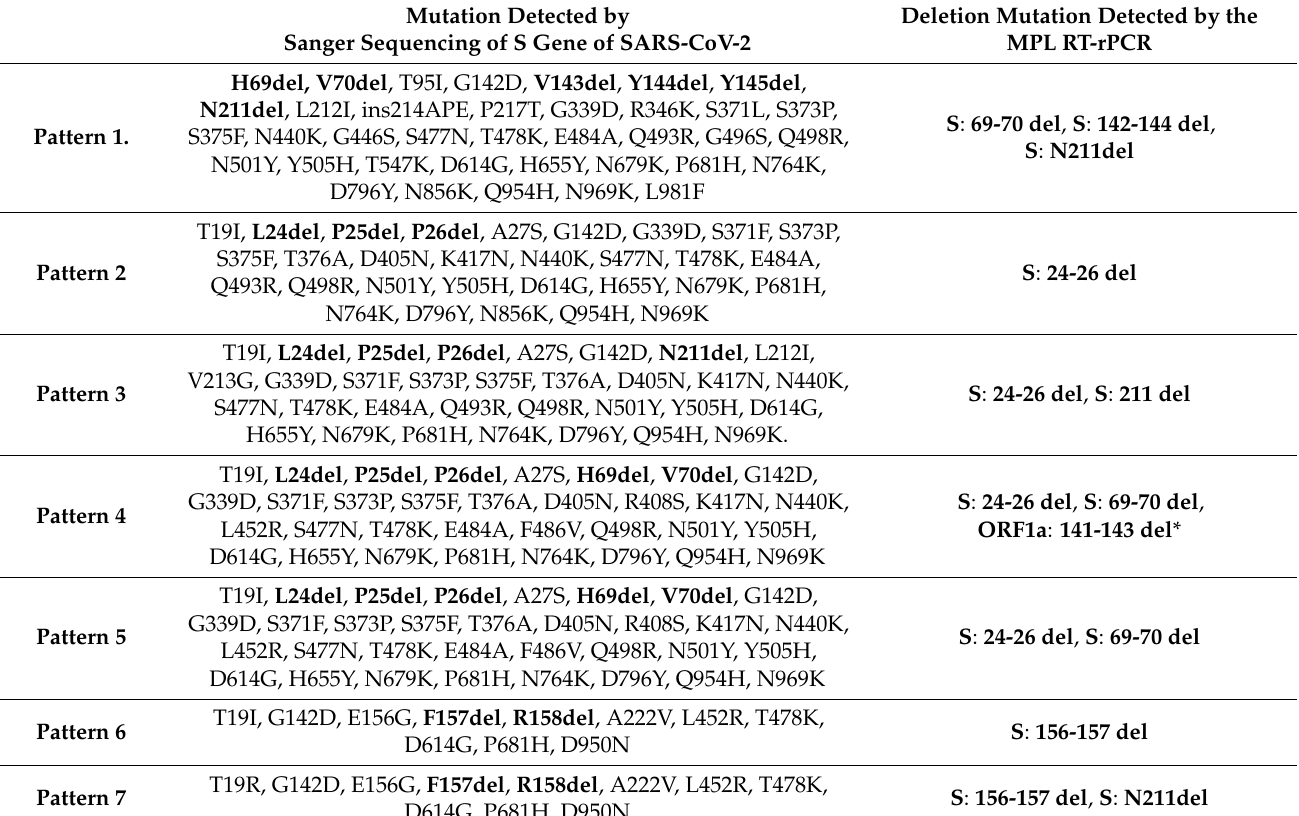
Table 3. The mutations detected in each pattern by Sanger sequencing and compared with the deletion mutations detected by the MPL RT-rPCR. Mutation Detected by Sanger Sequencing of S Gene of SARS-CoV-2